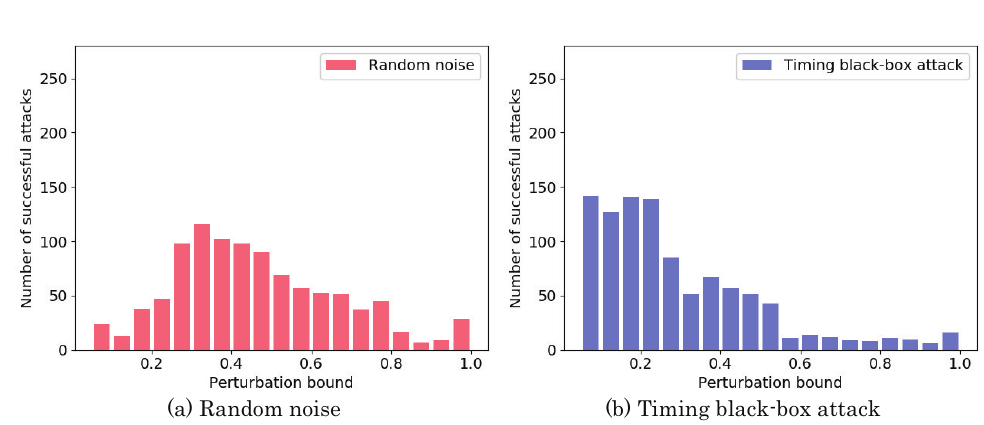
Figure 15: Histogram of successful attacks on 1,000 samples of CIFAR-10 dataset. Pro- posed attack is compared with random noise. Each perturbation bound is plotted when misclassification is caused by proposed attack and random